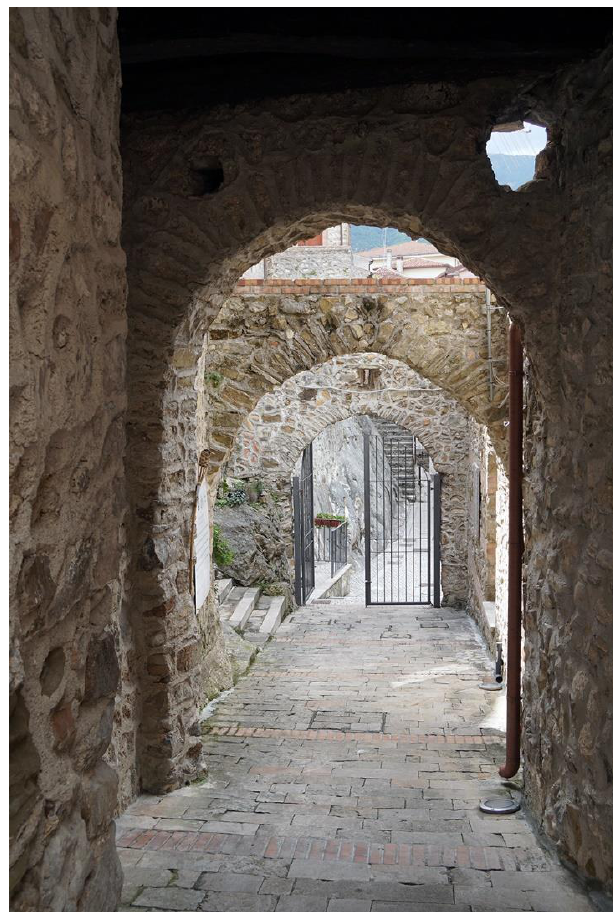
Figure 51. Quaglietta: Panoramic view of the castle and its medieval village completely restored after the 1980 hearthquake. Currently the medieval village is a tourist attraction as “albergo diffuso” (photos by [35,36]).